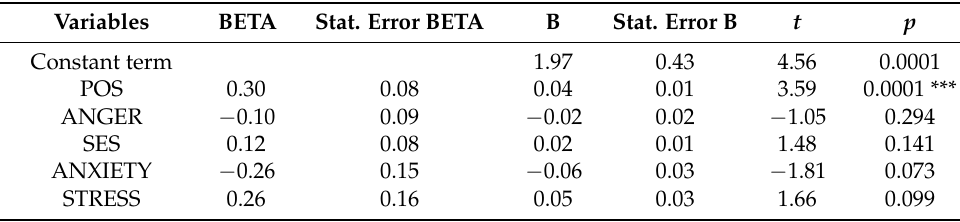
Table 10. Determinants of the ‘information support’ variable.